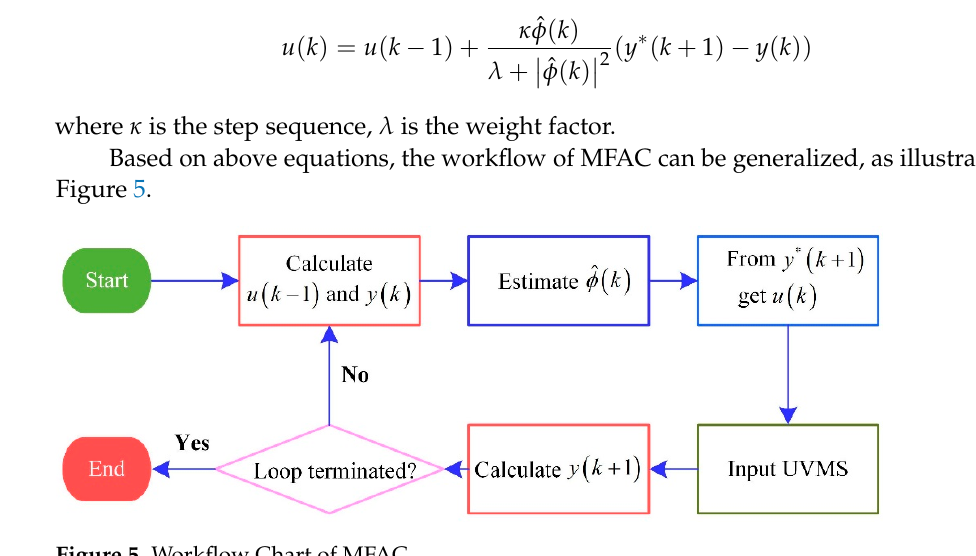
Figure 5. Workflow Chart of